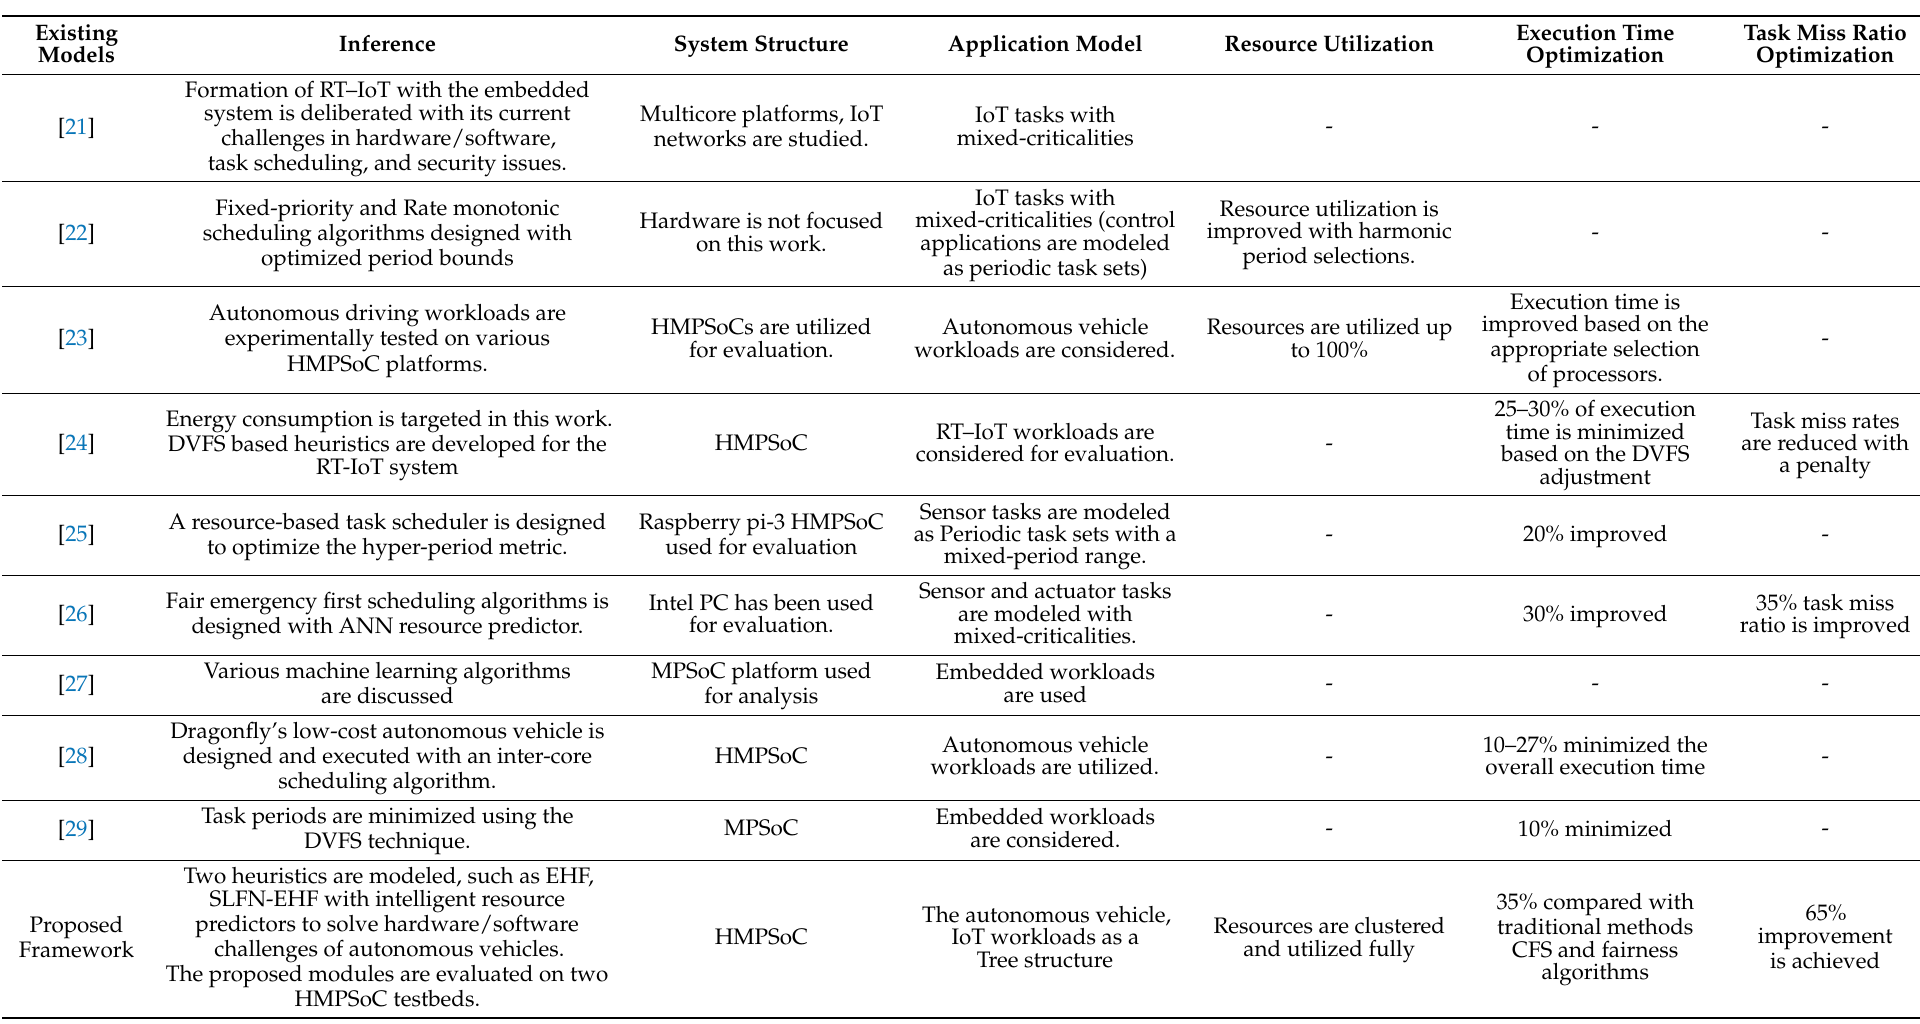
Table 1. Summarizing the Existing models with key